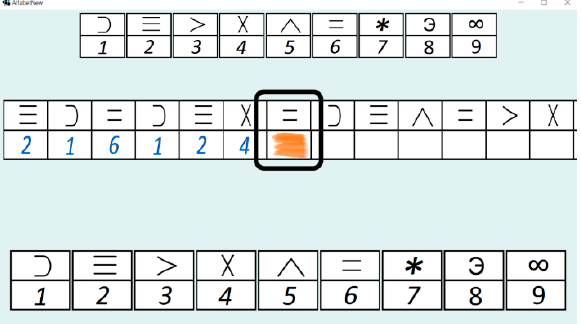
Figure 1. The interface of the application. The highlighted area presents the current symbol to be